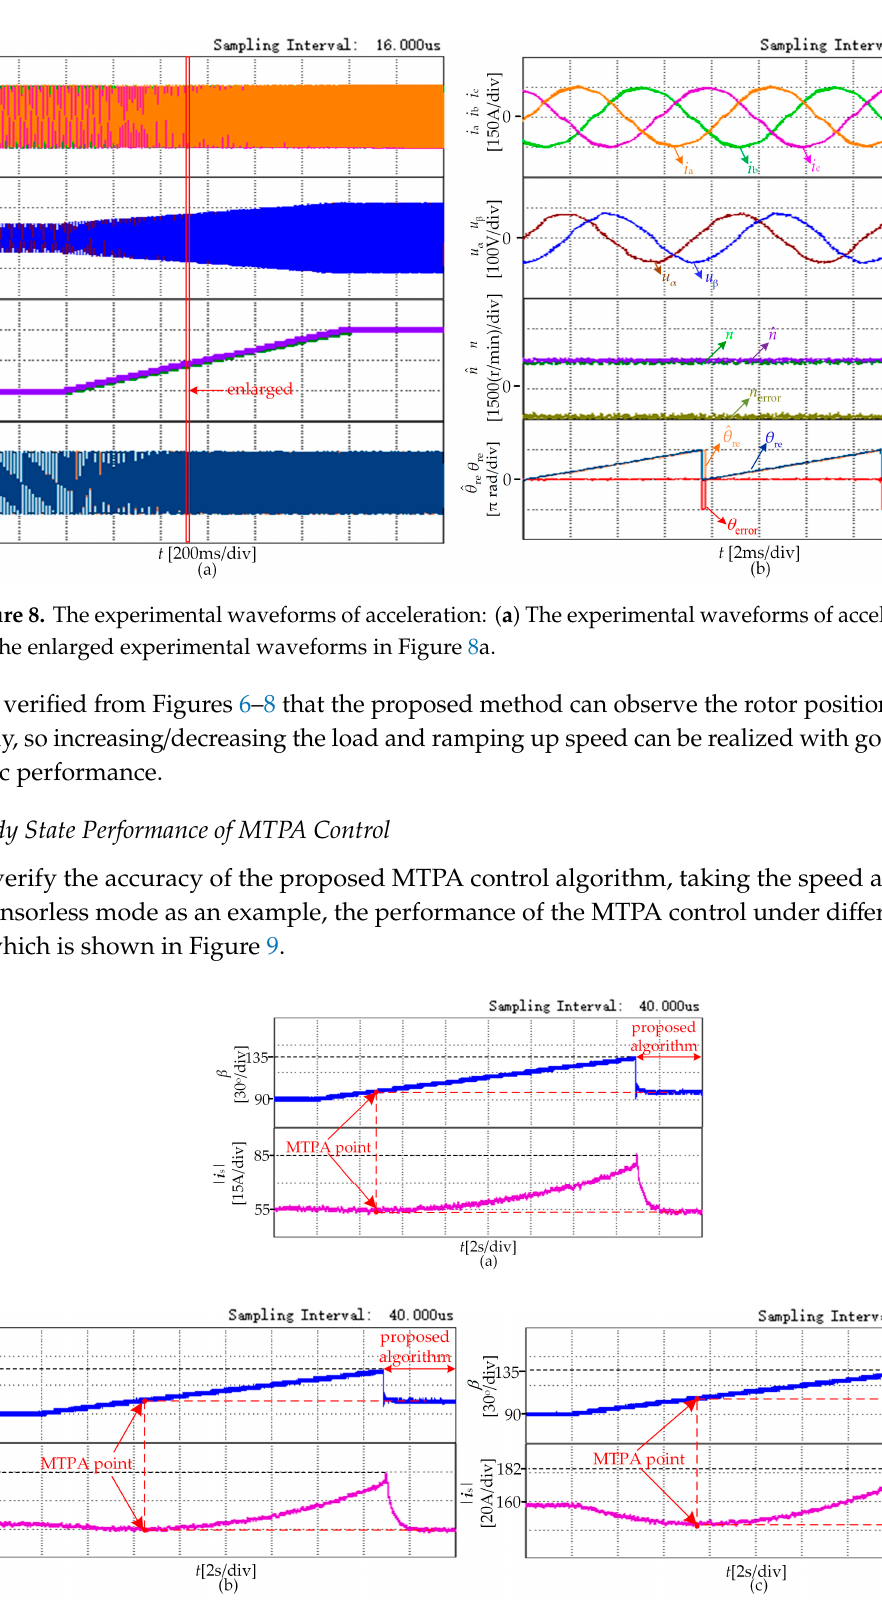
Figure 8 shows the experimental waveforms of acceleration with the proposed algorithm.